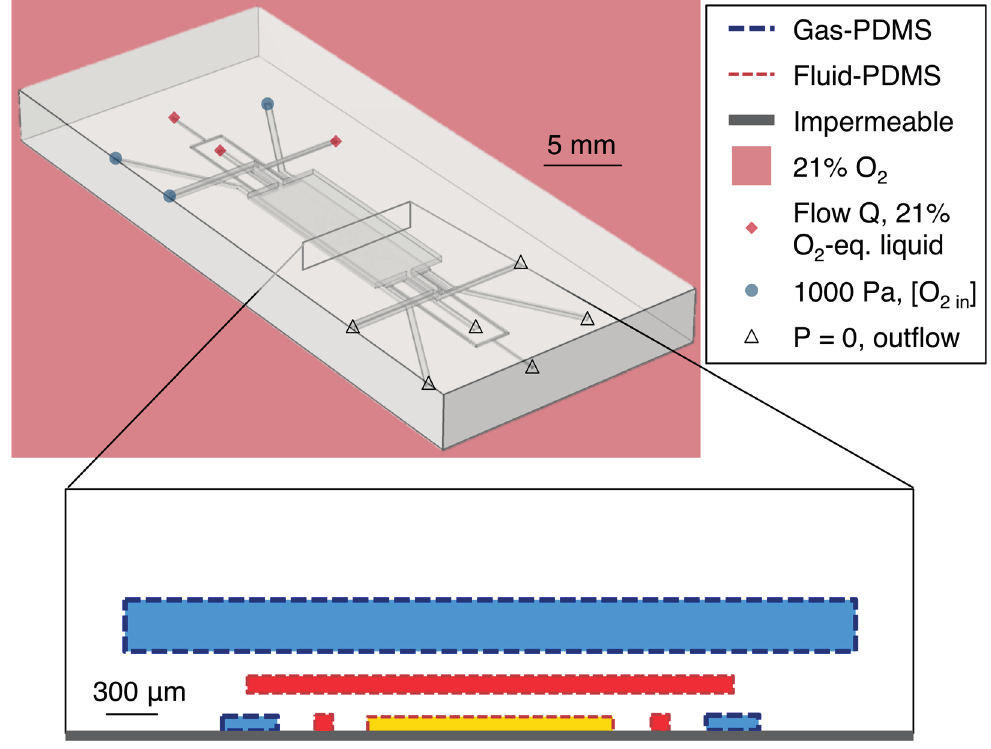
Figure 2. Simulation geometry and boundary types. Simulated channel heights were 100 μ m for layers 1 and 2 (C, L1H, L1GL, L1GR, L2H), and 300 μ m for layer 3 (L3G). Simulated PDMS membrane thicknesses were 100 μ m both between layers 1 and 2 and between layers 2 and